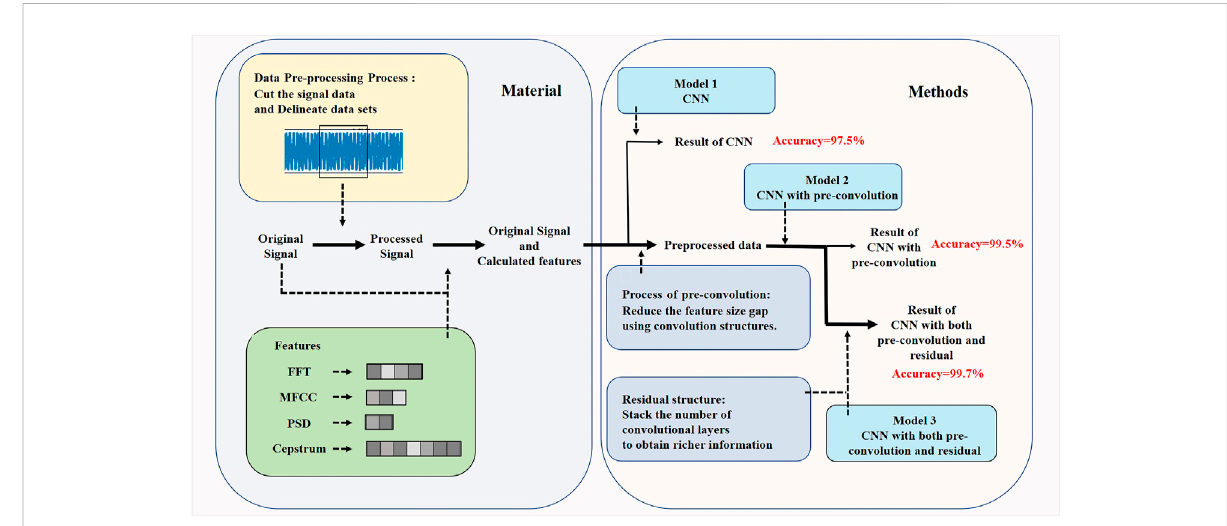
FIGURE 1 Damage detection model architecture diagram.